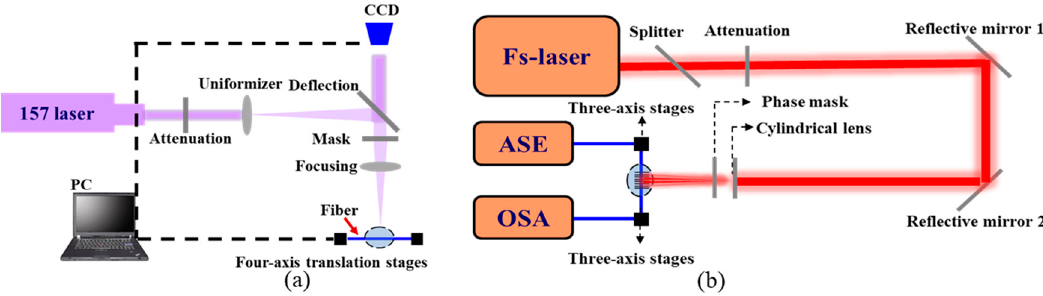
Figure 2. Schematic of the fabrication system. ( a ) 157 nm laser micromachining system; ( b ) 800 nm femtosecond laser system.